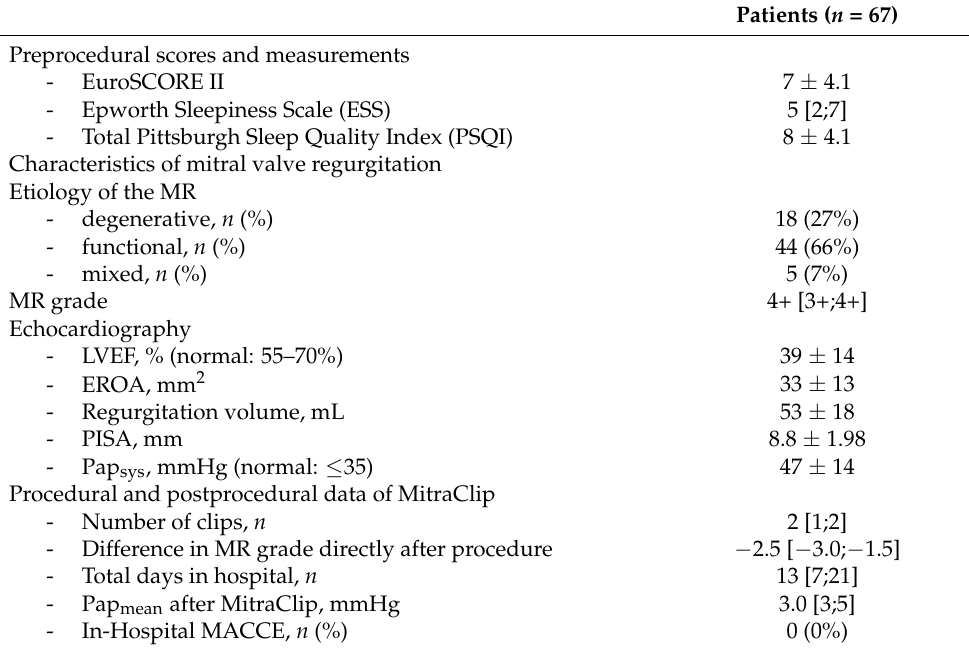
Table 2. Pre-procedural scores and measurements, characteristics of mitral valve regurgitation, and peri-procedural data of MitraClip intervention.